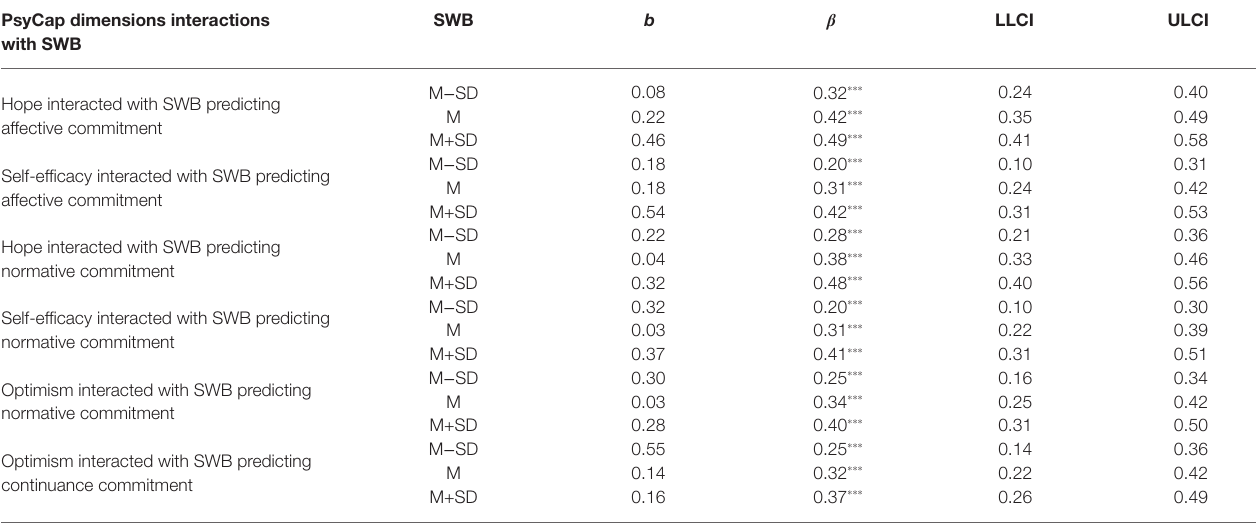
TABLE 2 | The predictive effect of psychological capital on career commitment at different levels of subjective well-being (SWB). PsyCap dimensions interactions SWB b β LLCI ULCI with SWB